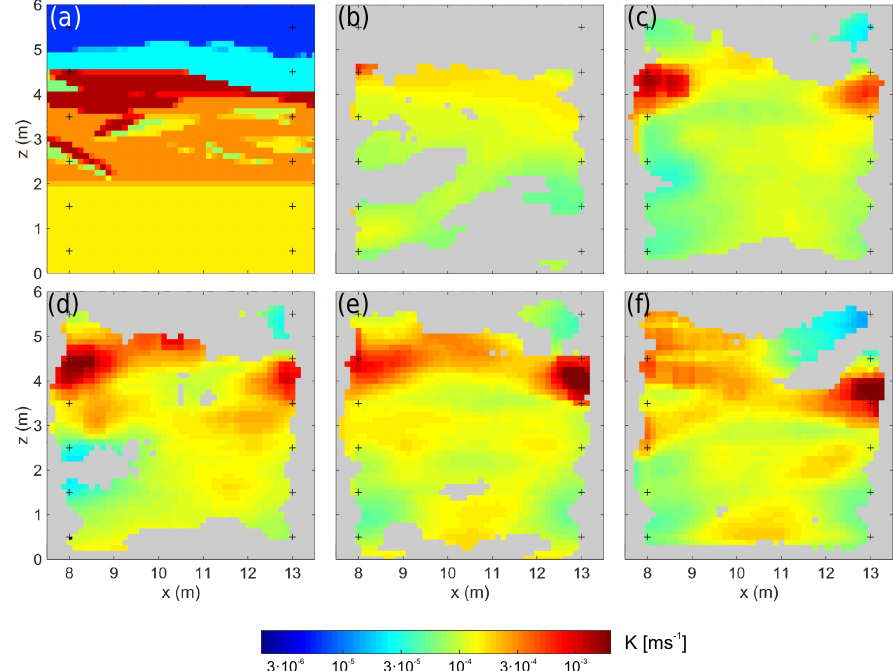
Figure 9. Hydraulic conductivity K reconstructions with different injection rates ( Q ). (a) Original K profile 1, (b) Q = 0.001Ls − 1 , (c) Q = 0.01Ls − 1 , (d) Q = 0.1Ls − 1 , (e) Q = 1Ls − 1 , (f) Q = 10Ls − 1